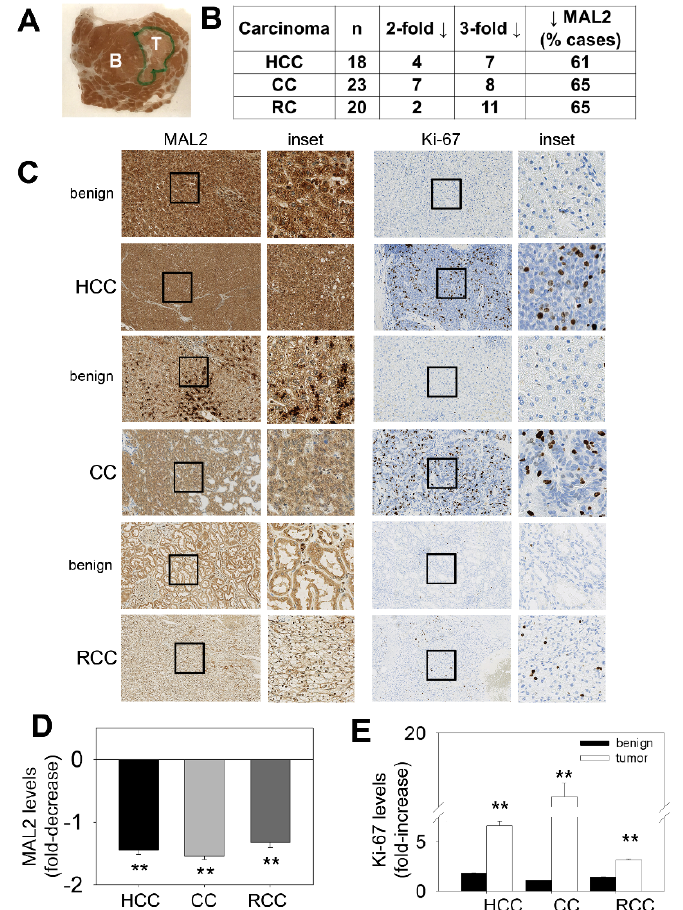
Figure 1. MAL2 expression patterns in human cancer tissue are consistent with its role as a tumor suppressor. ( A ) A liver biopsy was immunostained with diagnostically validated MAL2 antibodies. An unmagnified image of the biopsy mounted on the slide is shown. The areas containing the benign (B) and tumor (T) components are indicated. ( B ) Tumors from hepatocellular carcinoma (HCC), cholangiocarcinoma (CC) and renal cell carcinoma (RCC) biopsies were scored for MAL2 expression. Numbers of patient tumor samples that displayed 2- or 3-fold decreases in MAL2 protein expression are indicated. The total number of cases examined is shown (n) and the percent of cases examined that displayed decreased MAL2 protein expression is indicated. ( C ) Benign and cancerous lesions from human tissues from HCC, CC and RCC as indicated were immunostained with diagnostically validated MAL2 and Ki-67 antibodies. The black boxes indicate the regions of the micrograph enlarged insets. The fold-decrease in MAL2 expression ( D ) and fold-increase in Ki-67 expression ( E ) in cancerous lesions relative to benign across all patient biopsies are plotted. Values represent the mean ± SEM from 18 HCC patients, 23 CC patients and 20 RCC patients. ** p ≤ 0.001.